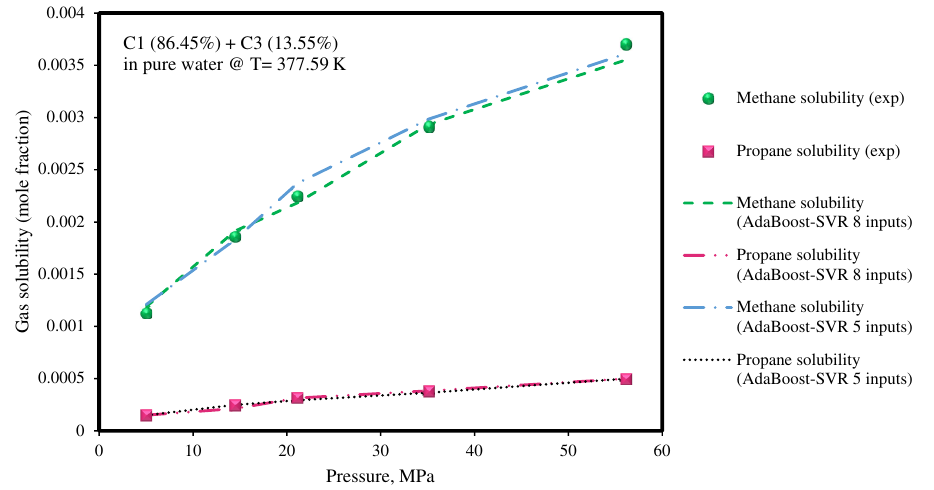
Figure 8. Experimental solubility data of methane and propane mixture in water at different operating pressures along with AdaBoost-SVR models predictions.